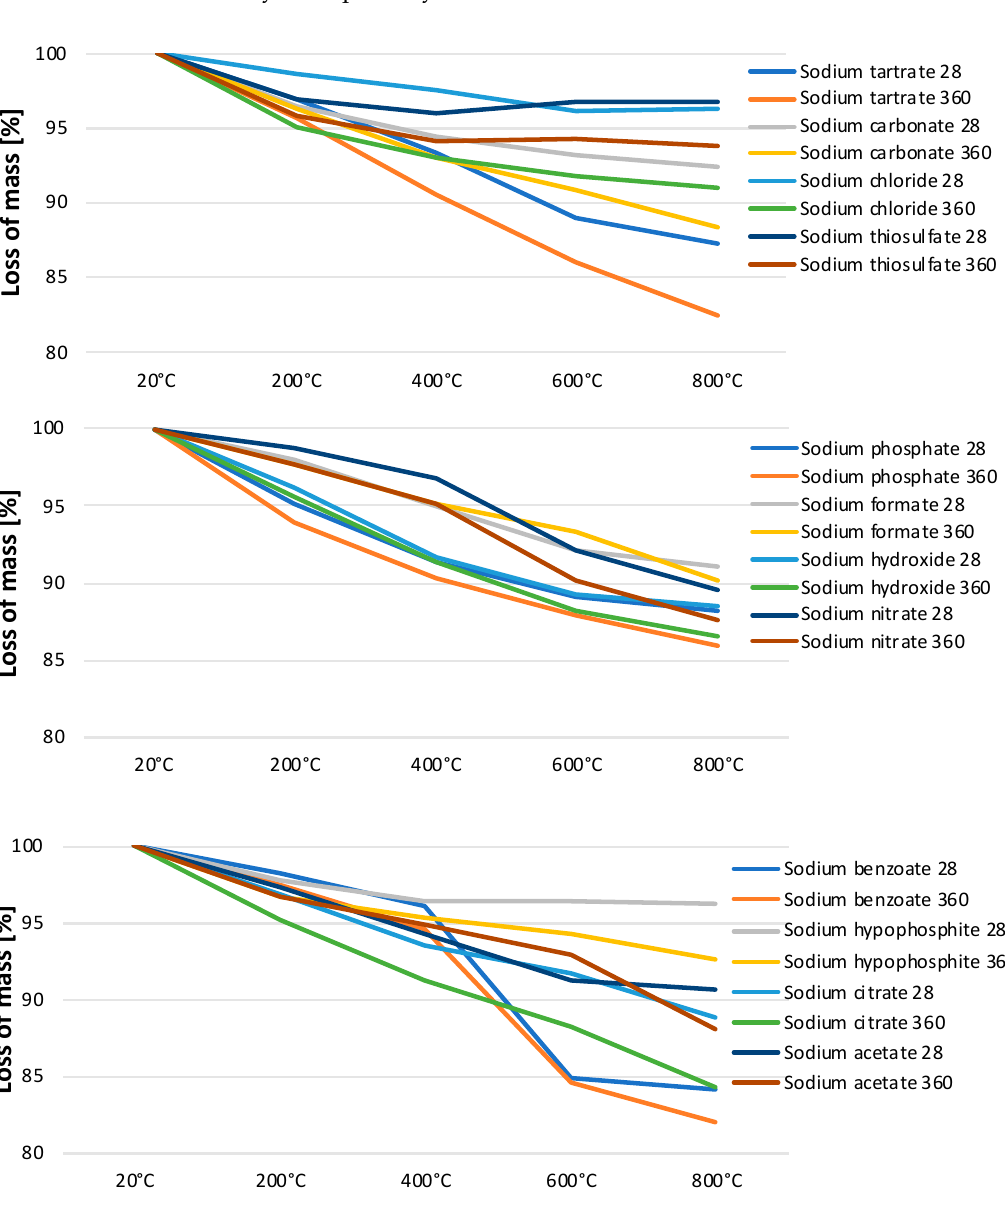
Figure 6. Loss on ignition during heating.